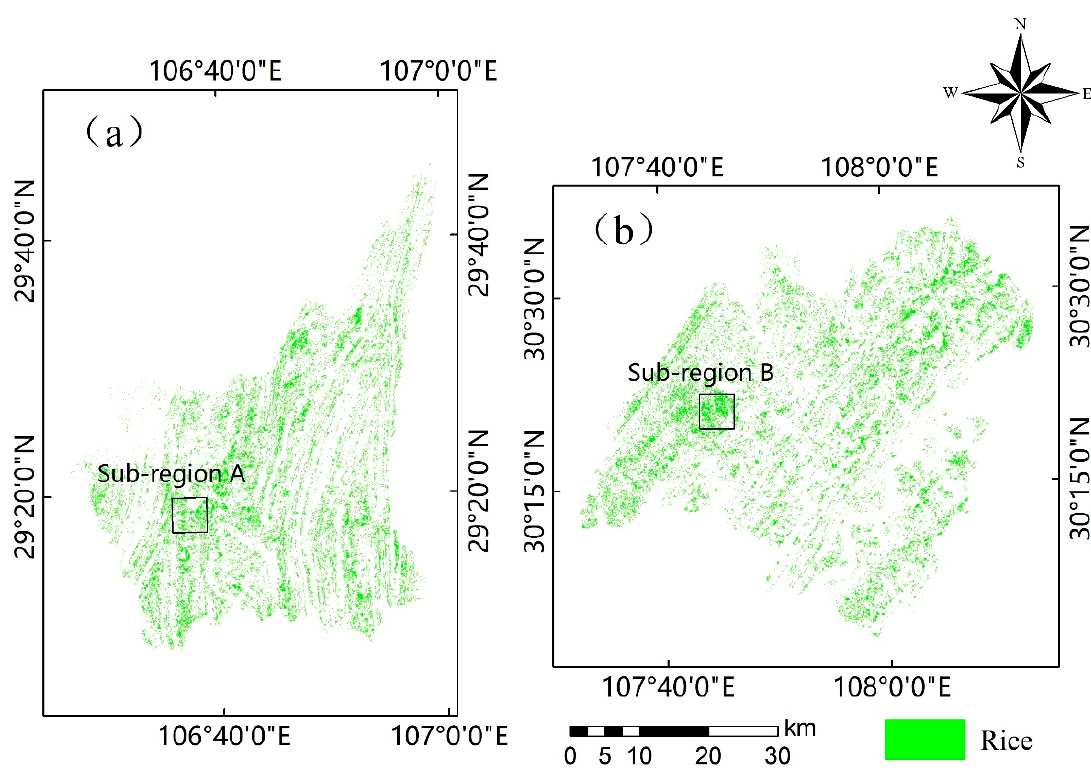
Figure 3. Paddy-rice map of the study area generated by Conv-2D in Banan District ( a ) and Zhongxian County ( b ) the two subregions with 5 km × 5 km were used to compare the detailed information created by the models).